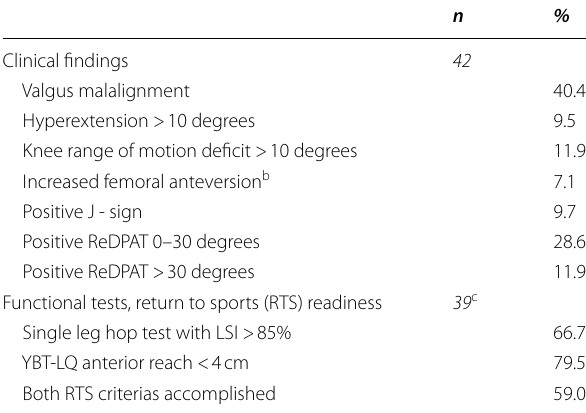
Table 3 Clinical findings and return to sport (RTS) readiness at follow‑up a